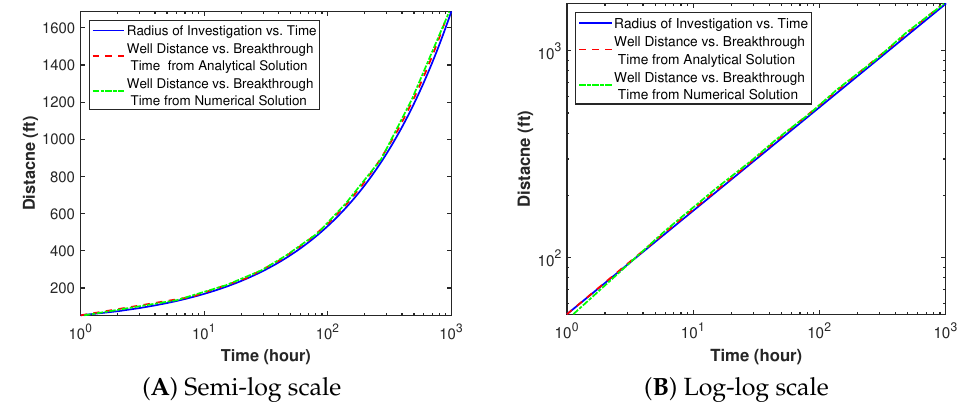
Figure 10. Radius of investigation versus time in semi-log and log-log